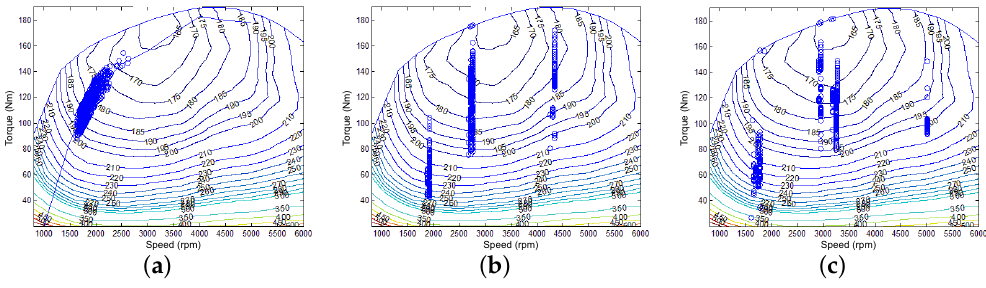
Figure 19. Engine working points of different EMS. ( a ) Power following control strategy. ( b ) Multi-workpoints control strategy. ( c ) A-MEMS.